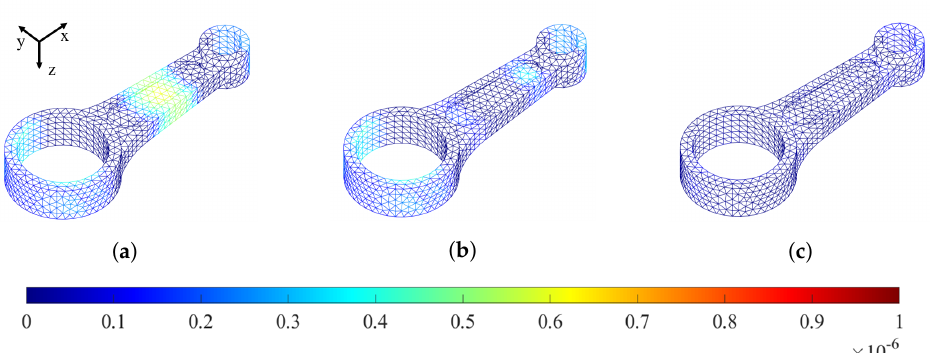
Figure 18. The error contour of the von Mises strain of the different error tolerance e i = 10%, 1%, and 0.1% for t = 0.207 s. ( a ) e i = 10%; ( b ) e i = 1%; ( c ) e i =